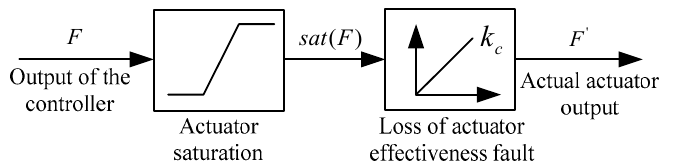
Figure 2. Description of the actual actuator output.